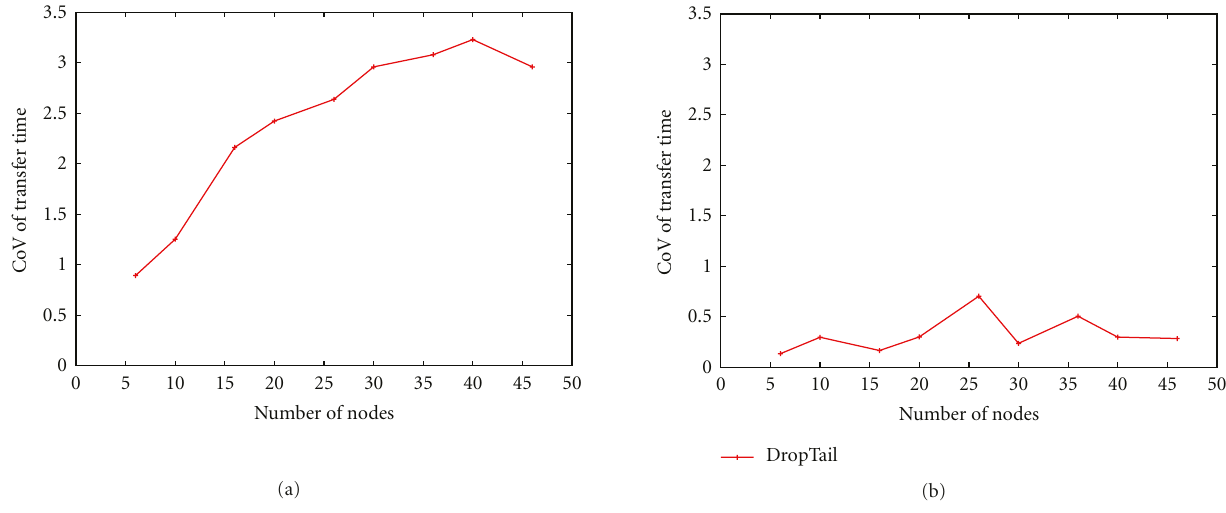
00.511.522.533.5